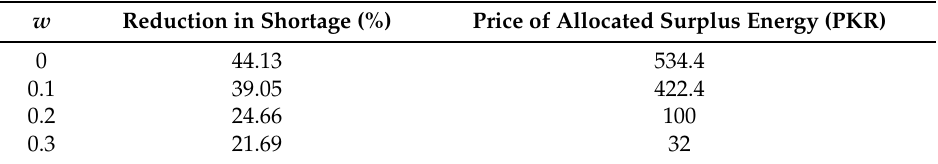
Table 2. Effect of weight ‘ w ’ on optimization